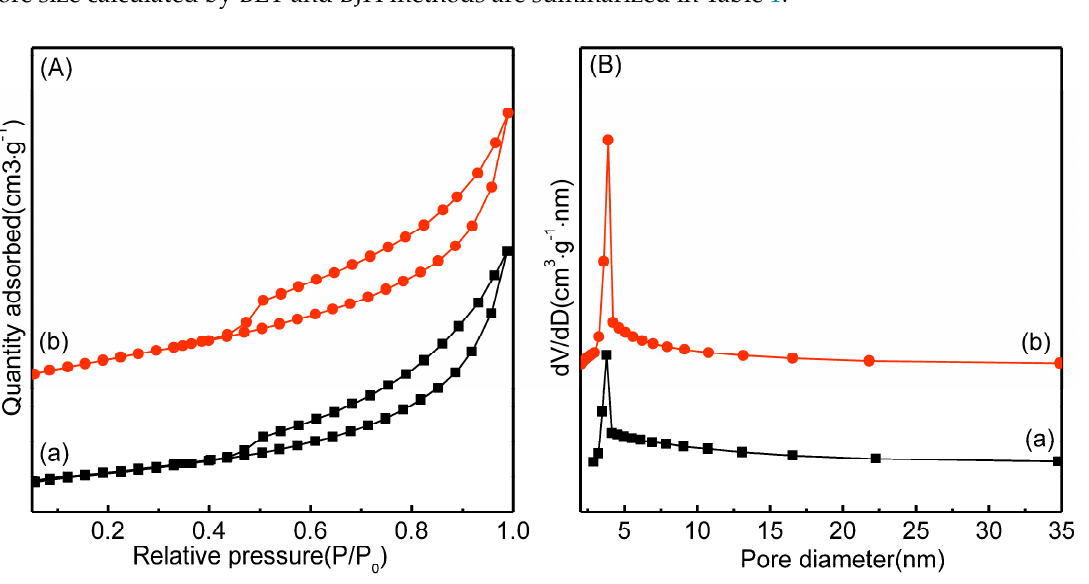
Figure 5. N 2 adsorption-desorption isotherms ( A ) and pore diameter distributions profiles ( B ) of Ni/Bentonite-U (a) and Ni-2wt%Mn/Bentonite-U (b).